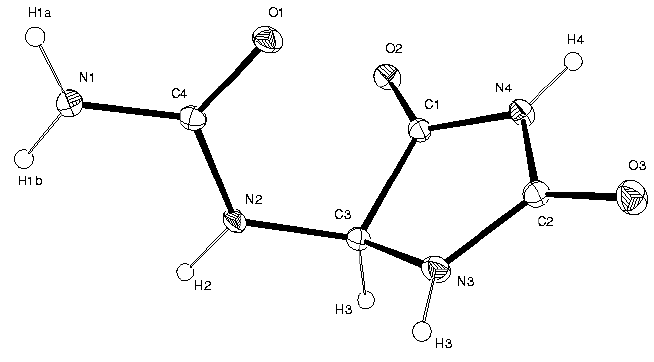
Figure 3. Molecular structure of natural allantoin from U. esculenta